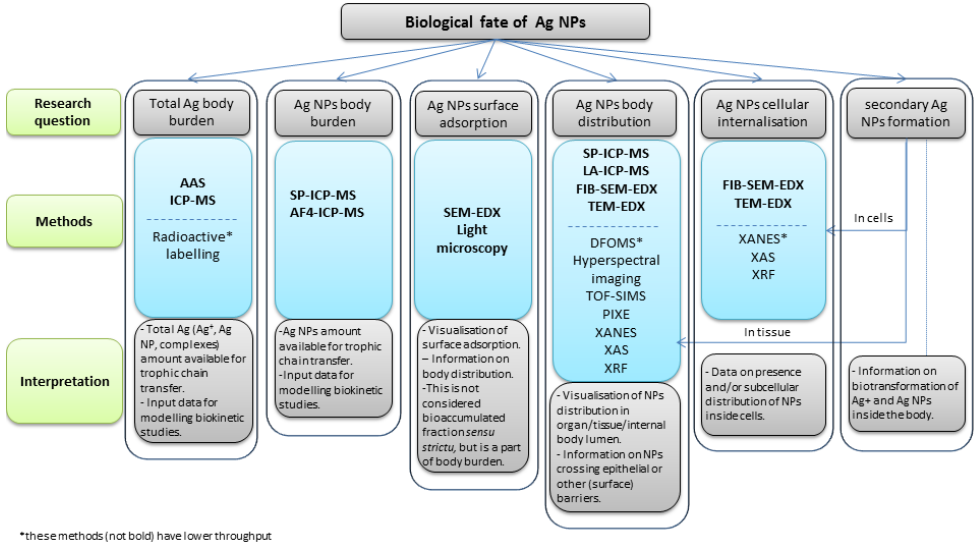
Figure 1. A decision scheme for selection of methods suitable for study of the biological fate of silver nanoparticles (Ag NPs) according to the specific research question.